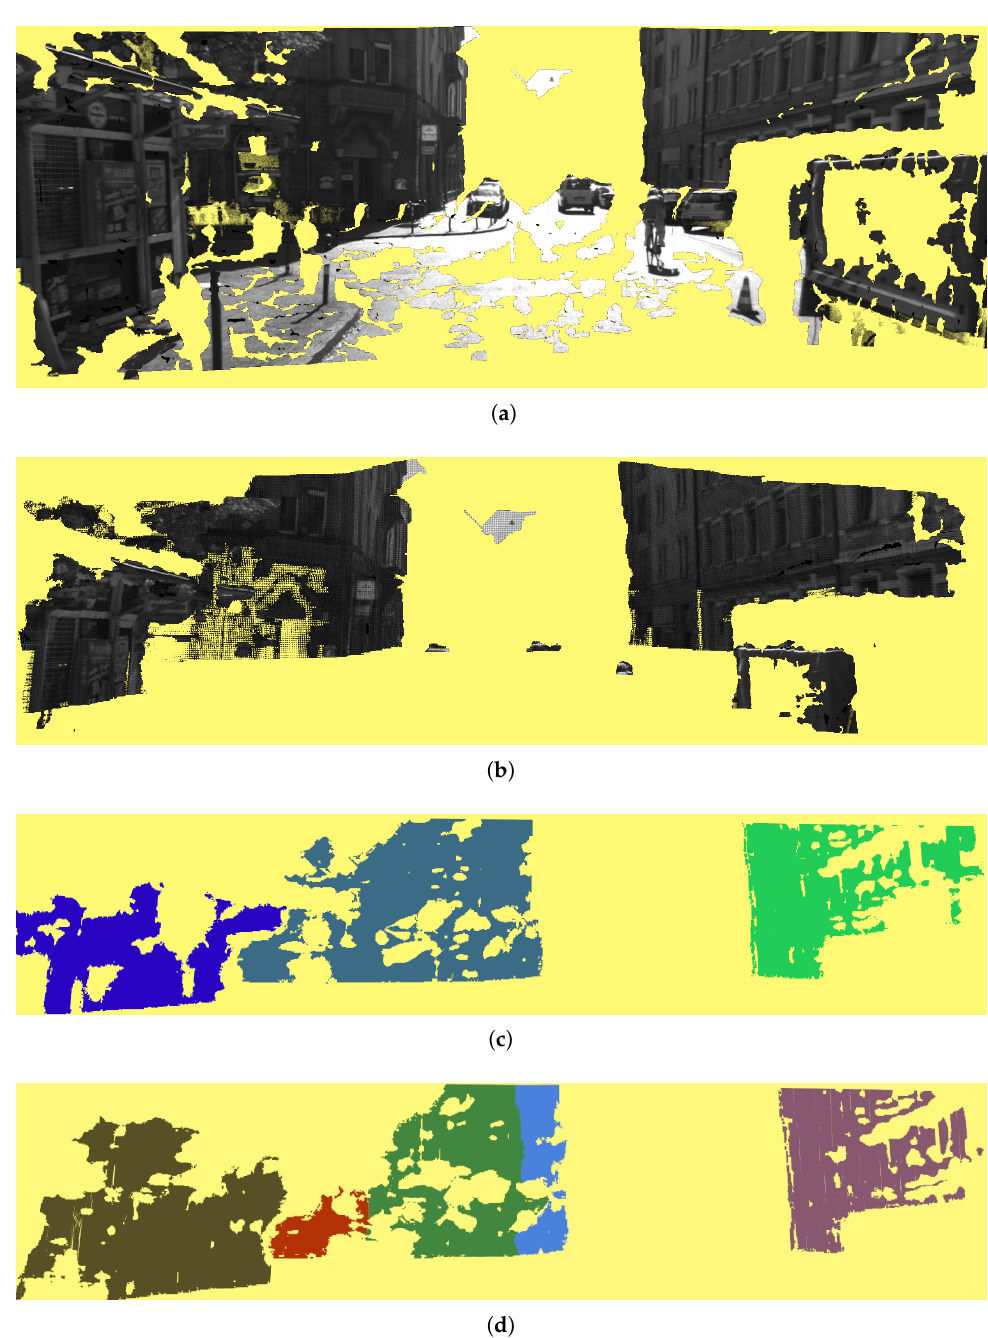
Figure 4. The figure depicts the steps of our previous pipeline. In yellow are the unreconstructed areas, i.e., the parts that will not be used in the reconstruction. ( a ) the point cloud from the SGMB phase, ( b ) the same image after the bounding box application. Please note that the façade structures are almost preserved. ( c ) depicts the results of the region growing segmentation algorithm, while in ( d ) the results after the final RANSAC iteration. The reconstruction quality and façade segmentation are poor in comparison with the current state-of-the-art CNN solutions shown in Figure